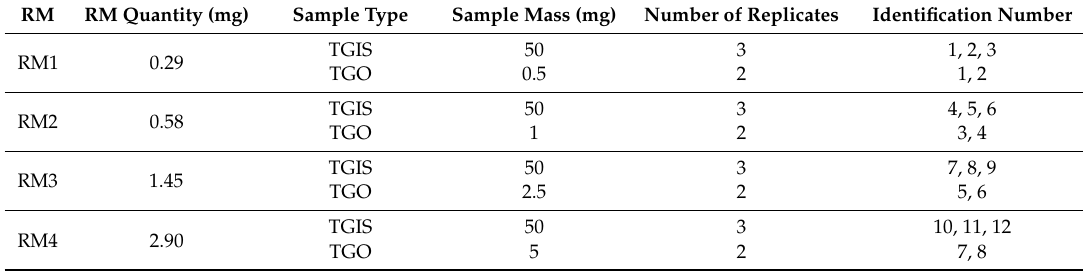
Table 1. Sample type, class, mass, rubber material quantity, number of replicates, and identification (RM) = rubber materials: RM1 = samples with rubber material concentration of 0.29 mg, RM2 = samples with rubber material concentration of 0.58 mg, RM3 = samples with rubber material concentration of 1.45 mg, RM4 = samples with rubber material concentration of 2.90